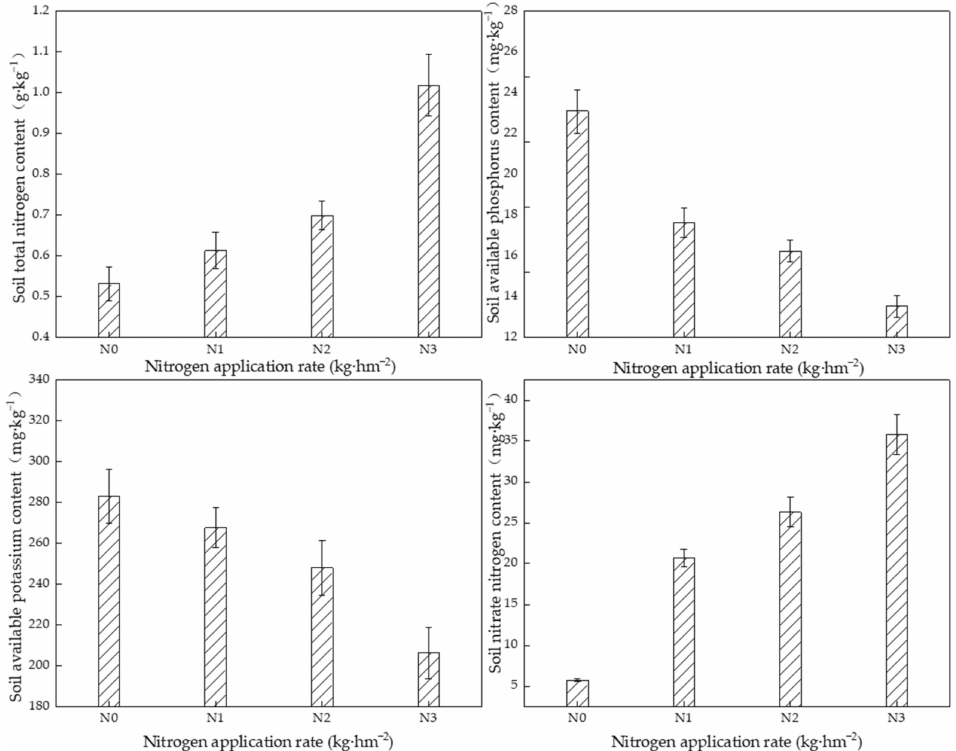
Figure 4. Effects of different nitrogen application rates on soil nutrient content in Populus tomentosa